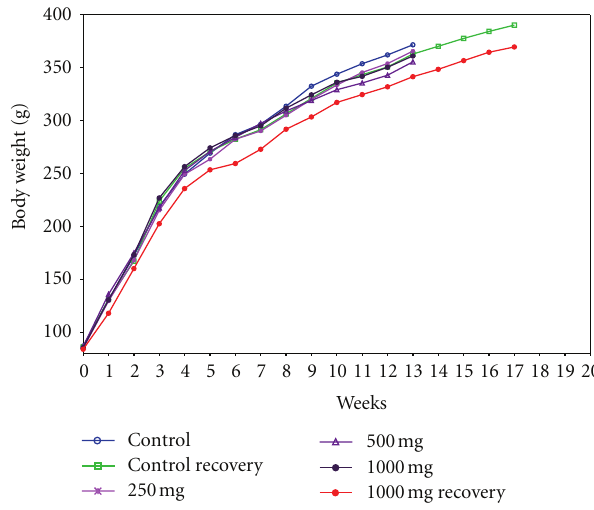
Figure 1: Group mean body weight of male rats orally administered with Zigbir (cid:2) for 90 days.